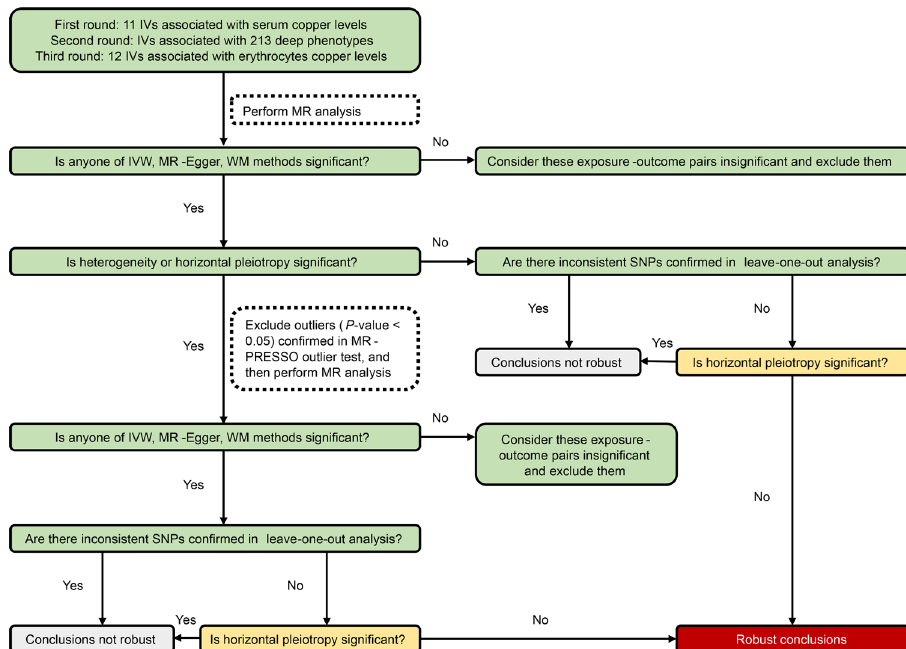
Fig. 6 Flow chart of the two-sample Mendelian randomization analysis in East Asian and European populations. IVs instrumental variables, MR Mendelian randomization, IVW inverse-variance weighted, WM weighted median, MR-PRESSO Mendelian randomization pleiotropy residual sum and